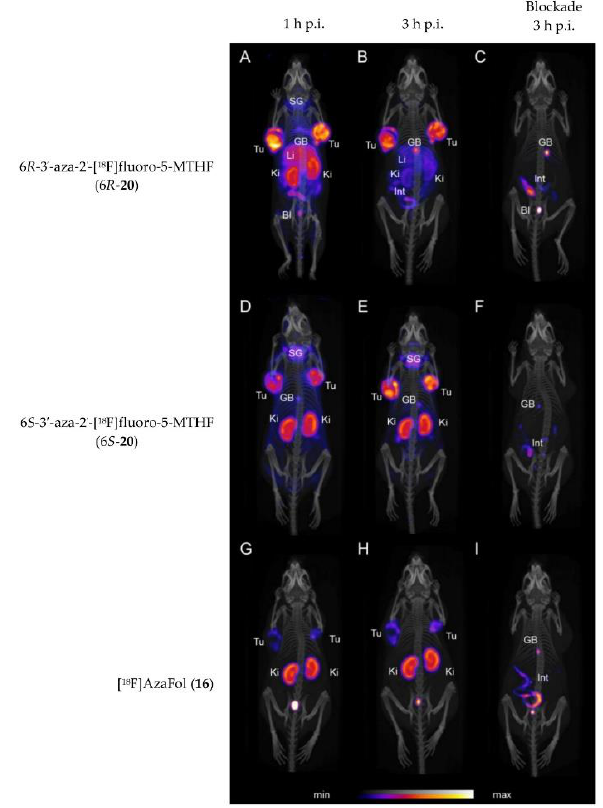
Figure 7. PET/CT images of KB tumor-bearing mice at 1 and 3 h p.i. and treatment with folic acid at 3 h p.i. of 6 R - 20 ( A – C ), 6 S - 20 ( D – F ) and 16 ( G – I ). Tu = KB tumor; Li = liver; Ki = kidney; SG = salivary glands; GB = gall bladder; BI = urinary bladder; Int = intestines / feces. This figure was adapted from Boss et al. [63].